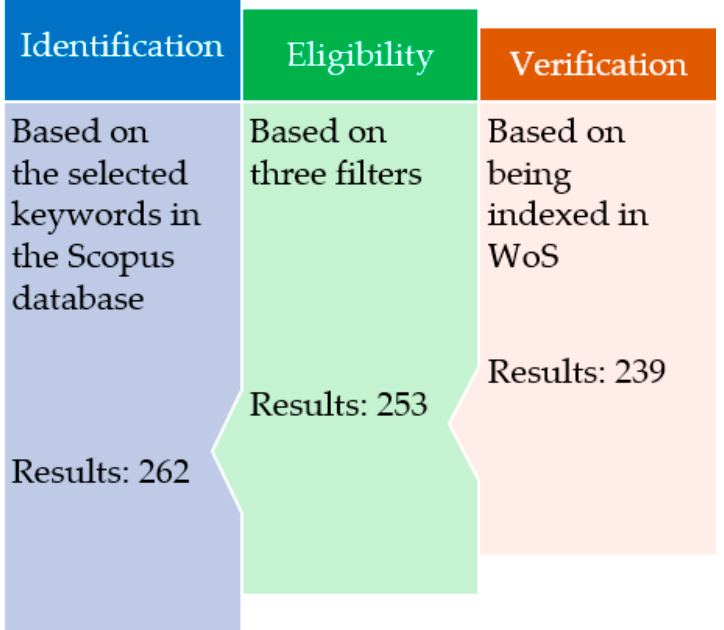
Figure 5. Methodology diagram of selected articles.